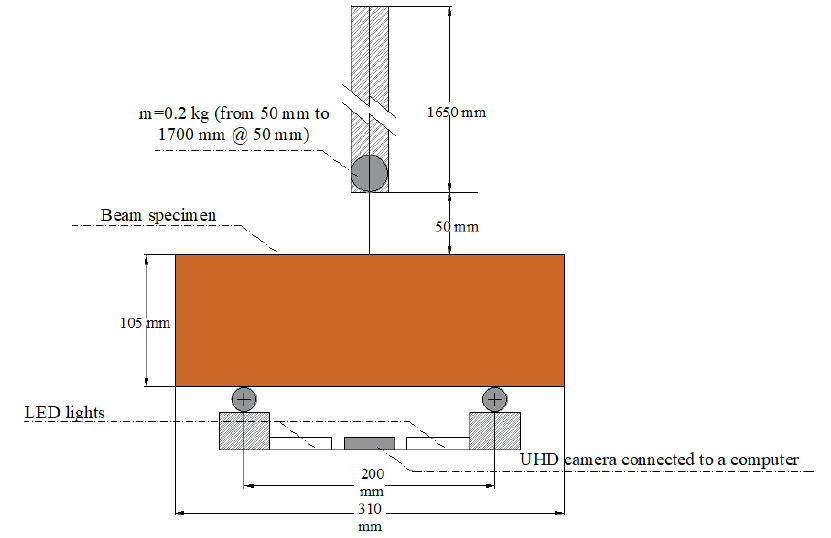
Figure 6. Impact strength test setup.